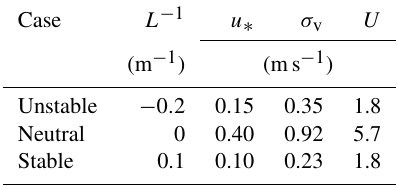
Table 2. Flow conditions assumed for the example calculations.